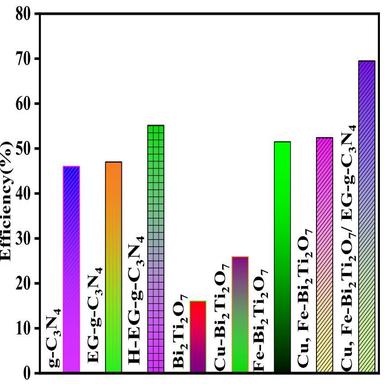
Ciprofloxacin degradation efficiencies by the prepared catalysts.